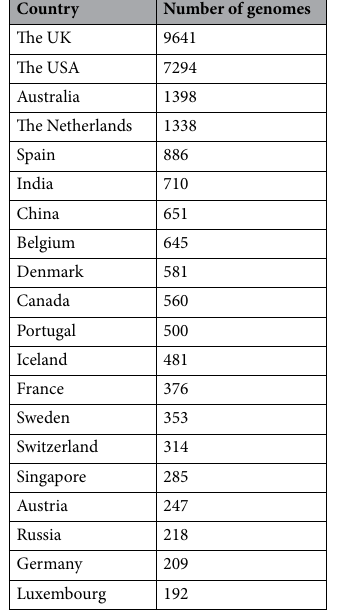
Table 1. 20 countries with the largest number of genomes in the dataset.